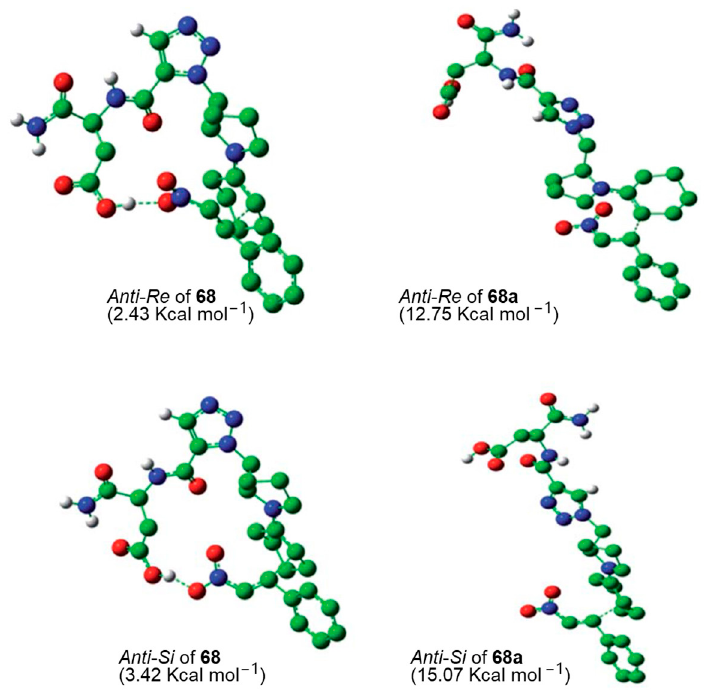
Figure 9. Preferred transition states for catalyst 68 and 68a . Adapted with permission from [51].